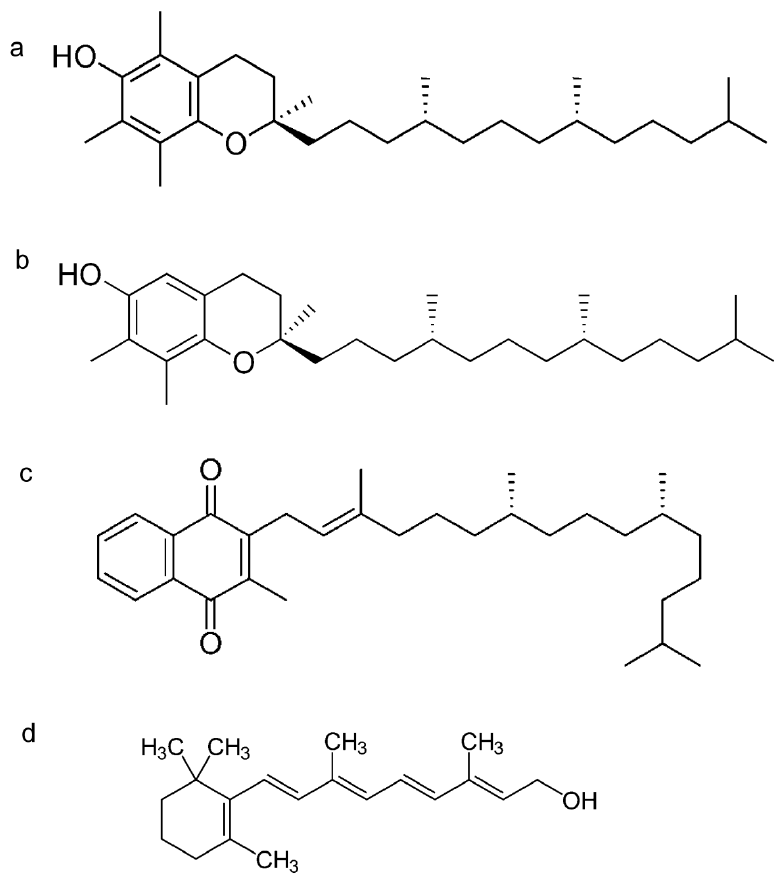
Figure 3. Chemical structures of: ( a ) alpha tocopherol, ( b ) gamma-tocopherol, ( c ) phylloquinone, and ( d ) retinol.